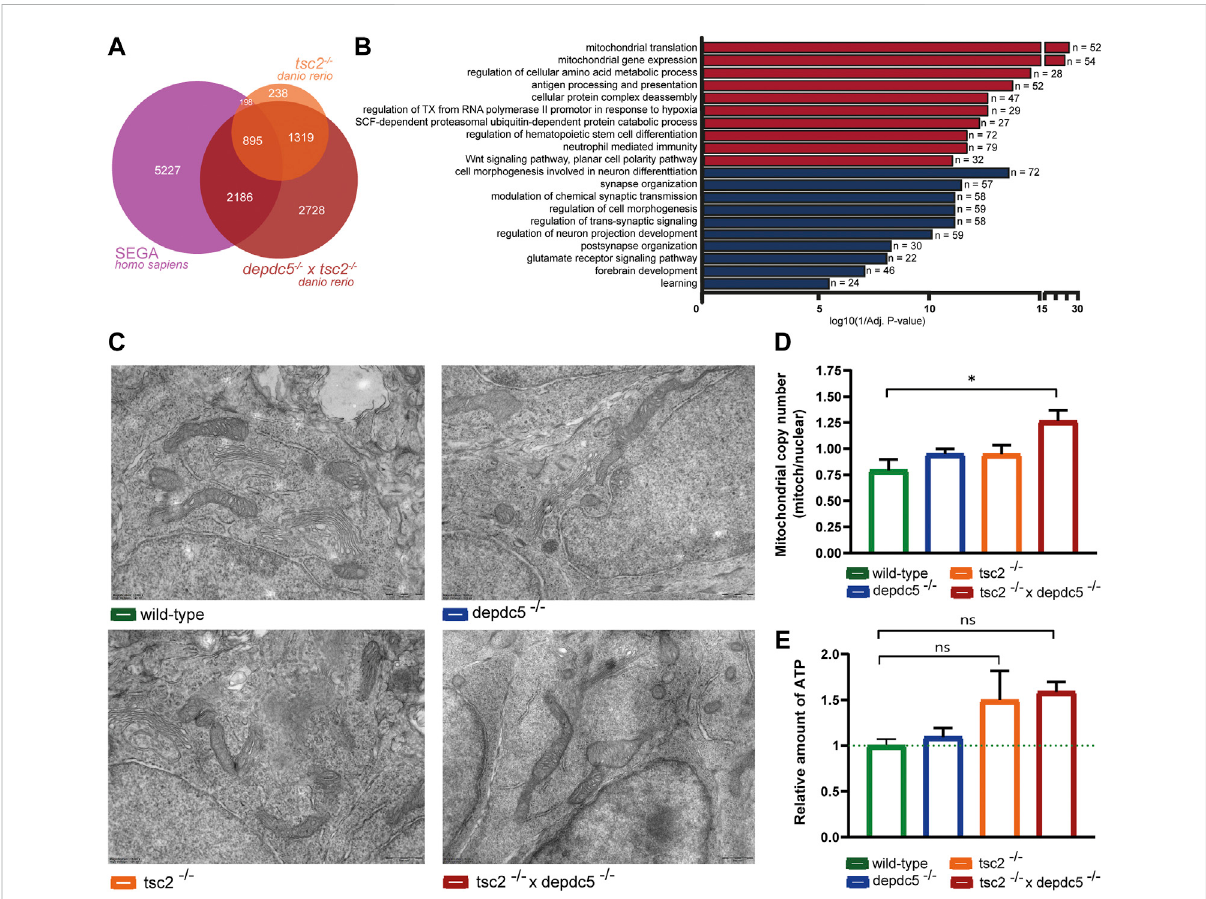
FIGURE 5 Comparison of the transcriptome of double homozygous zebra fi sh larvae and human SEGA samples. (A) Overlap of differentially expressed genesbetween tsc2 − / − zebra fi shlarvae , doublehomozygouszebra fi shlarvae(afterconversiontohumanorthologs)andSEGAsamples.38%and13% oftotalDEGsintheSEGAtranscriptomewerefoundtooverlapwiththedoubleandtsc2homozygotestranscriptome,respectively.AChi-squaretest indicated that there was a statistically signi fi cant association ( p = 2.2e-16) between the zebra fi sh genotype and the proportion of overlapping genes. (B) Enriched GO terms from up and downregulated genes that are shared between double homozygous zebra fi sh larvae and human SEGA samples. Terms enriched amongst upregulated genes are indicated in red, terms enriched amongst downregulated genes are indicated in blue. The x-axisrepresents thelog10 (1/ p -value),nindicatesthenumberofgenesappearingineachcategory. (C) Representativeelectron microscopyimages (scalebar;500 nm)visualizingmitochondriainwild-type, depdc5 − / − , tsc2 − / − , anddoublehomozygouszebra fi shlarvaeat5dpf. n =1larvae/group